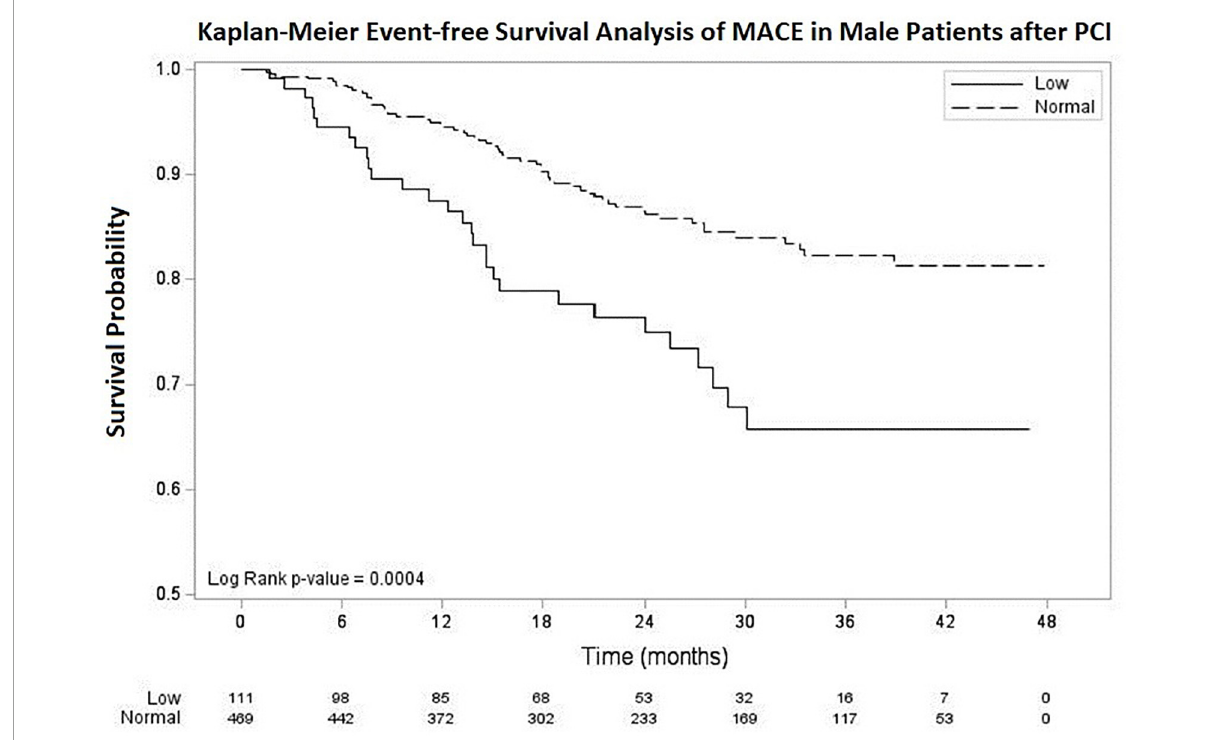
FIGURE1 Kaplan–Meier survival curve for MACE in male patients after PCI with low and normal testosterone level. The average survival time was 25.22 ± 0.88 months in low testosterone group (testosterone < 3.25 ng/mL) and 35.09 ± 0.47 months in normal testosterone group (testosterone ≥ 3.25 ng/mL). MACE, major adverse cardiovascular events. PCI, percutaneous coronary